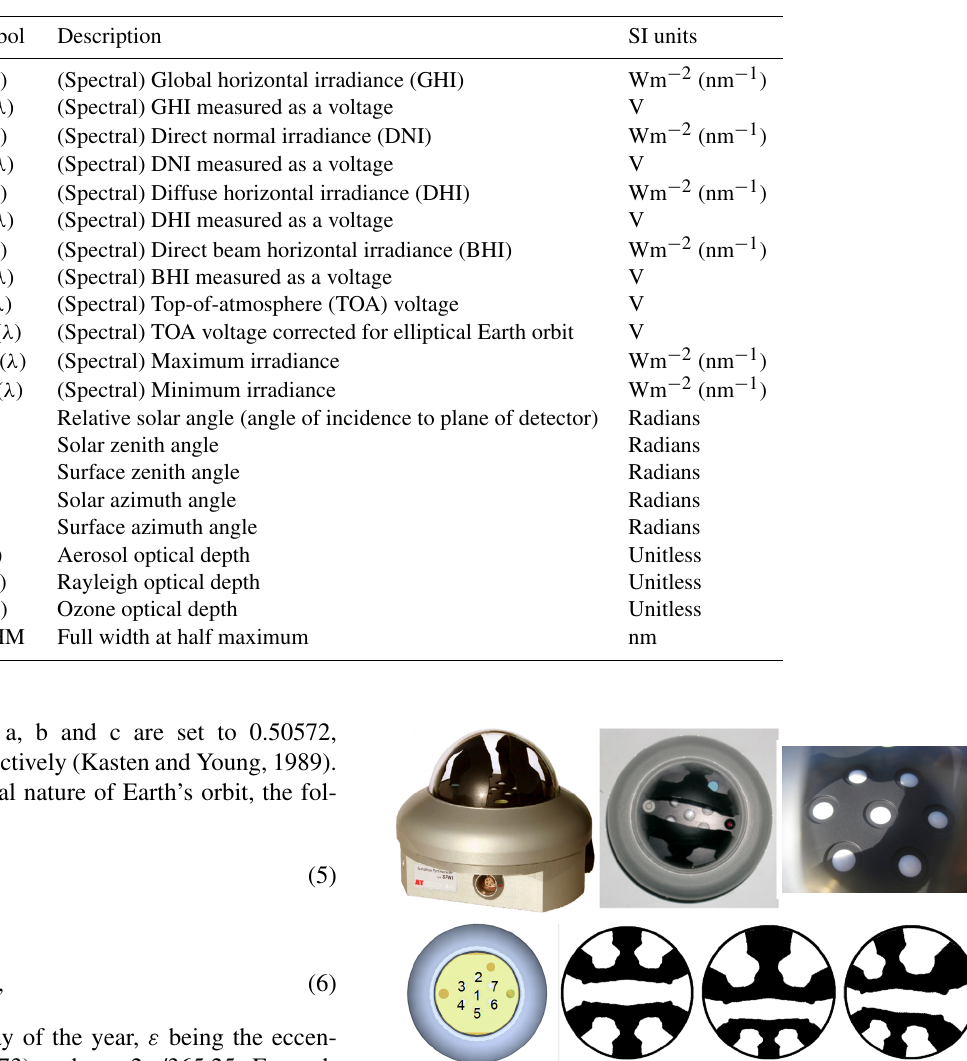
Table 1. Glossary of terms and symbols.